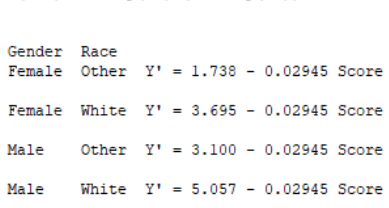
Figure 7. Logistic regression model.